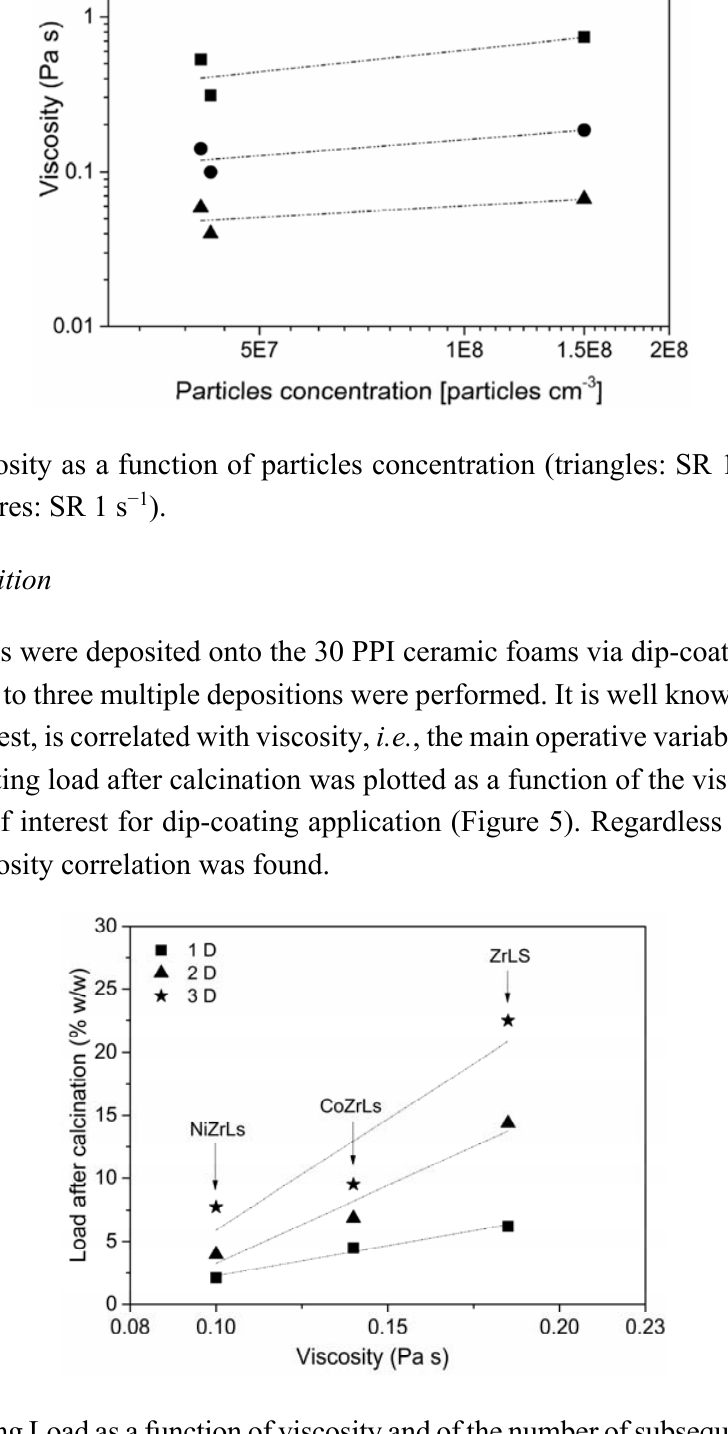
Figure 5. Coating Load as a function of viscosity and of the number of subsequent depositions. As expected, the washcoat load increased with viscosity and was observed at any dipping